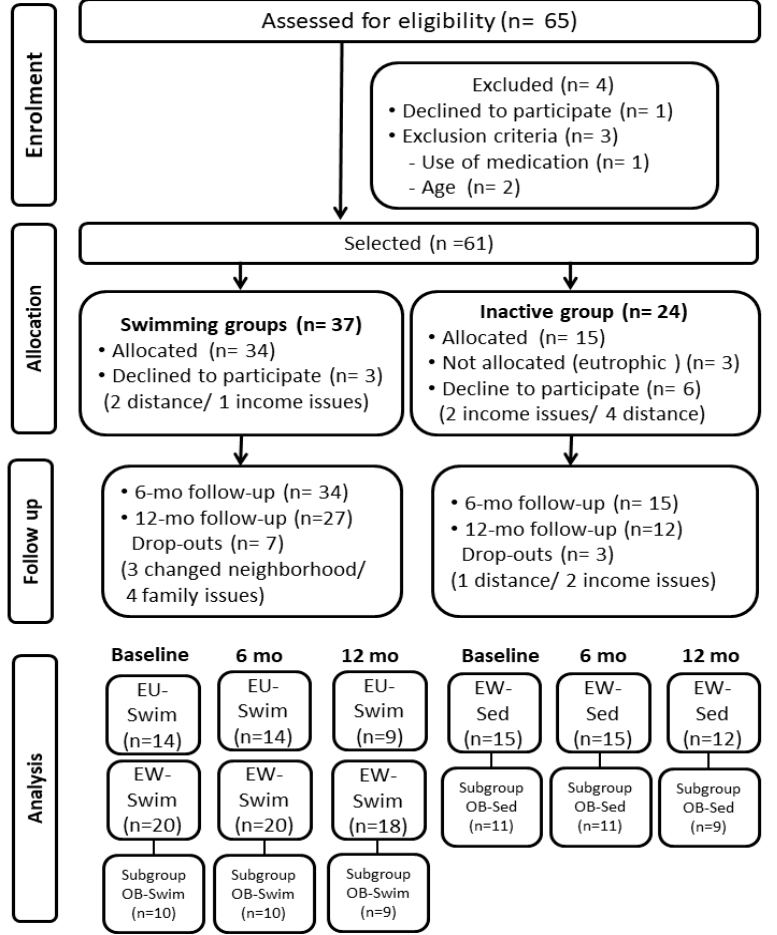
Figure 1. Flow diagram of the study.